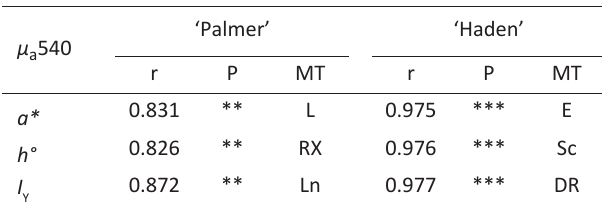
Table 6 - Results of regression analysis between